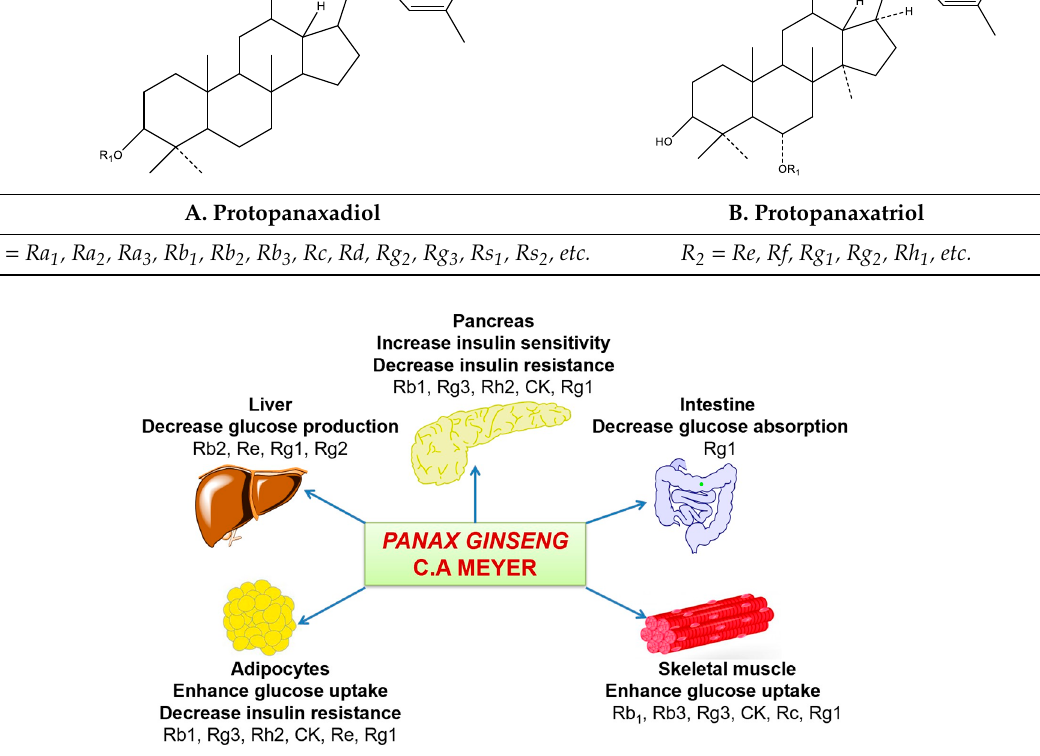
ff erent organs related to